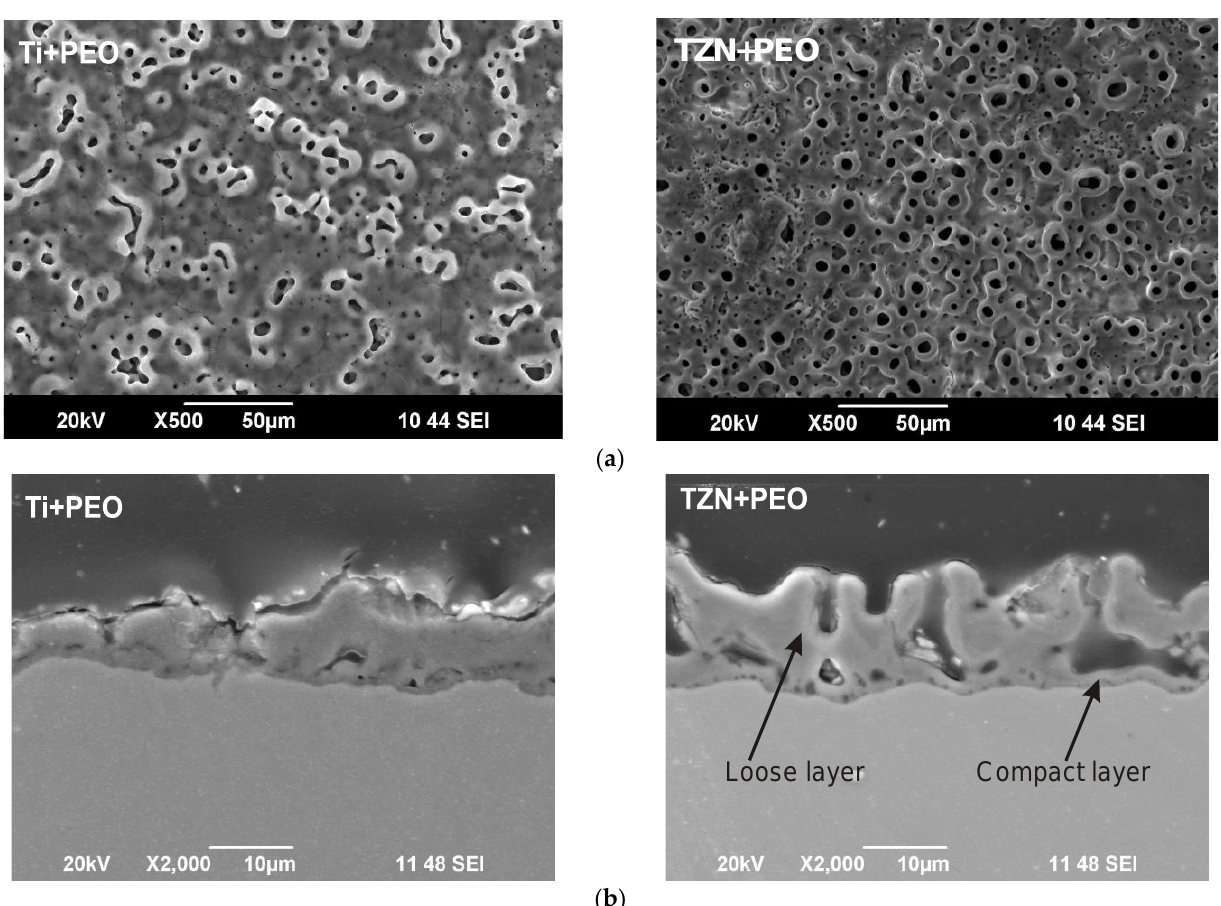
Figure 2. SEM images of the PEO coating for Ti+PEO and TZN+PEO samples: ( a ) Top view; ( b ) cross-section. Table 1. Surface properties of the PEO treated samples Ti+PEO and TZN+PEO.